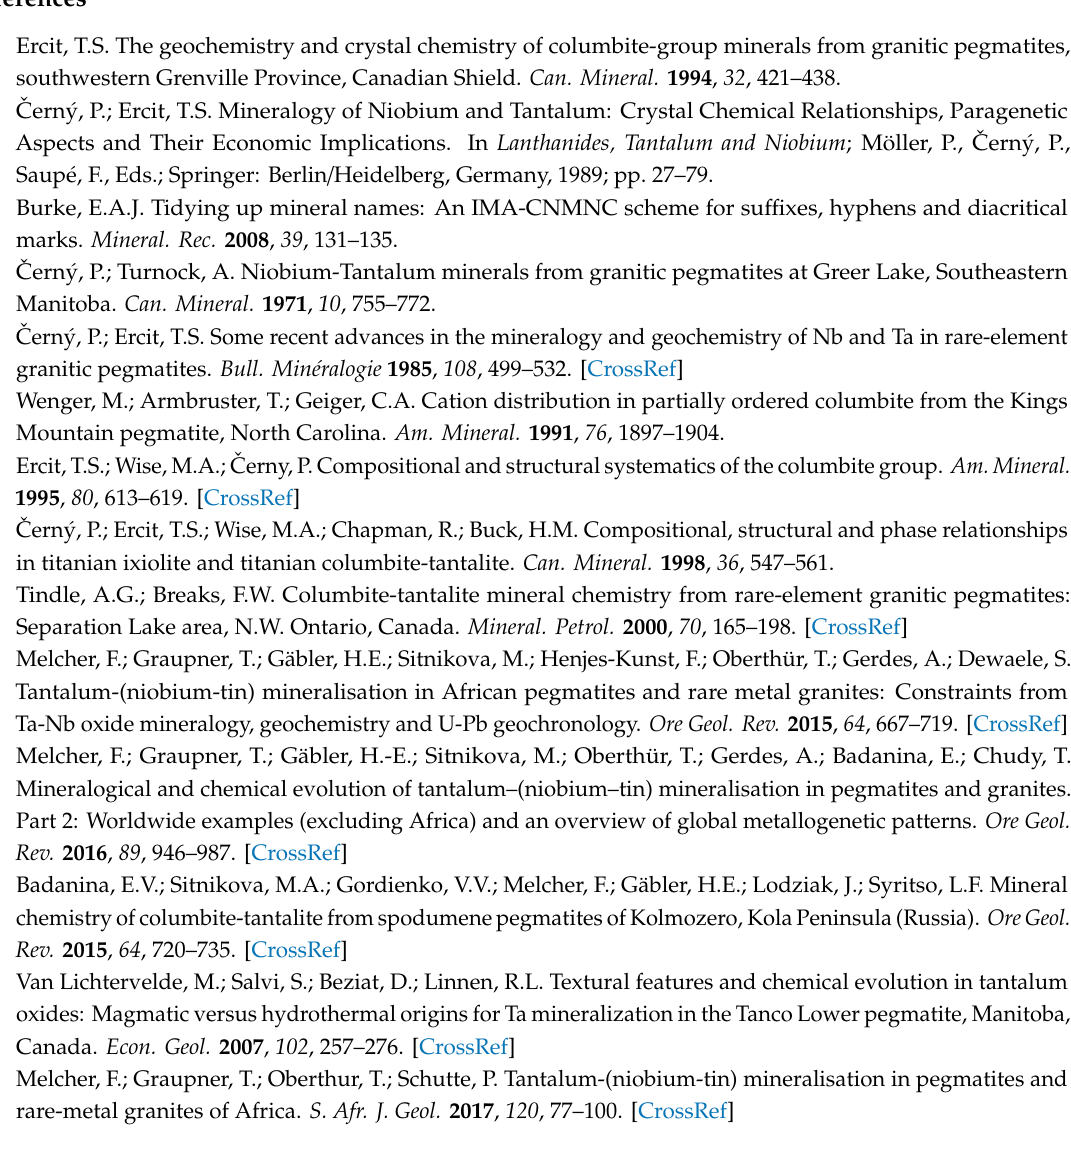
Table S1: WDS compositions (wt.%) and structural formulae (apfu) for the columbite crystals from the Desemborque Pluton, Table S2: Trace element compositions (ppm) for the columbite crystals from the Desemborque